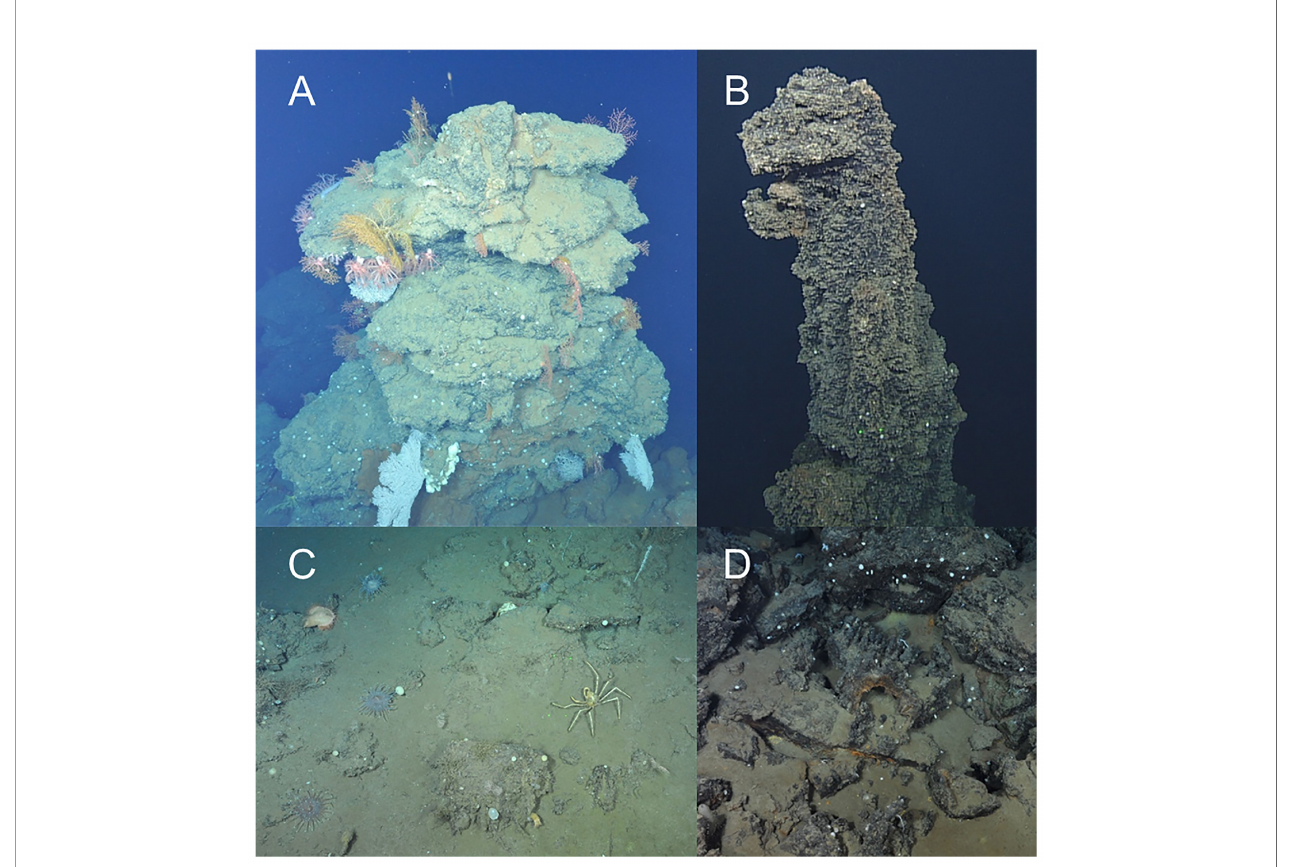
FIGURE 2 | Photographs of inactive sul fi de deposits at Endeavour and Middle Valley captured by ROPOS in August 2016. (A) An inactive chimney (dive R1939) populated with corals (Alcyoniidae spp., Plexauridae spp., Primnoidae sp. 1 and Primnoidae sp. 3), sponges (Demospongiae sp. 1 and white encrusting), and a holothurian ( Pannychia moseleyi ); (B) ‘ Big Bad Ben ’ , the > 30-m tall inactive chimney (dive R1938); (C) Sedimented sul fi de rubble (dive R1943) colonized by jewelled and fl y trap anemones ( Corallimorphus sp. 1 and Actinoscyphia aurelia ), stalked barnacles (Scalpellidae sp. 1), bamboo coral ( Lepidisis sp. 1), schizopathid corals ( Umbellapathes sp. 1), ascidians, and an oregoniid ( Macroregonia sp. 1) crab; (D) Sul fi de rubble with fragments of a toppled chimney (dive